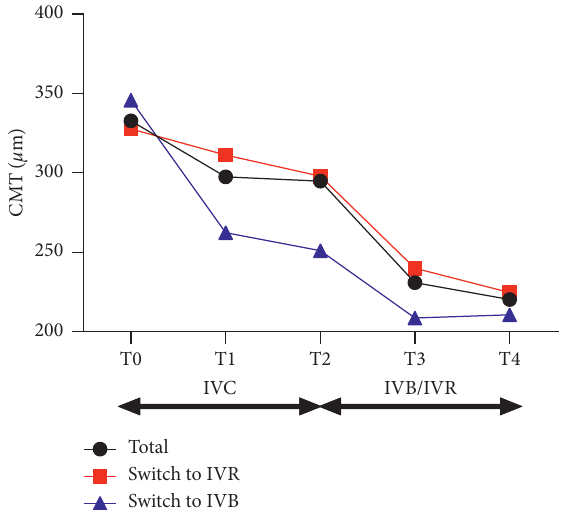
Figure 3: Changes of the mean mPEDH in eyes with persistent nAMD. The mPEDH did not change statistically significantly during the treatment of IVC. But it significantly reduced after switching to IVR or IVB from 384.3 ± 340.3 μ m to 287.2 ± 245.2 μ m at T3 and 265.3 ± 226.4 μ m at T4. The mean change of mPEDH from T2 to T4 was significantly larger in the IVR subgroup than that in the IVB subgroup ( p � 0 . 023). mPEDH, maximum PED height; PED, pigmented epithelial detachment; IVC, intravitreal injections of conbercept; IVB, intravitreal injection of bev- acizumab; IVR, intravitreal injection of ranibizumab; T0, baseline visit; T1, 1 month after the first ICV; T2, 1 month after 3 monthly IVC; T3, 1 month after the first IVR or IVB; T4, 1 month after the last IVR or IVB.